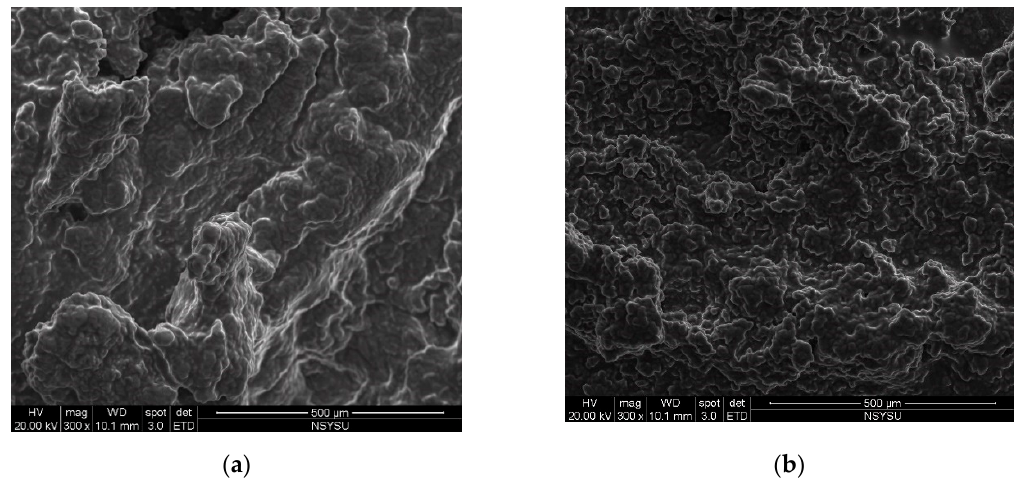
Figure 4. Scanning electron microscope (SEM) micrographs of ( a ) cobia liver and ( b ) cobia liver pretreated with papain.